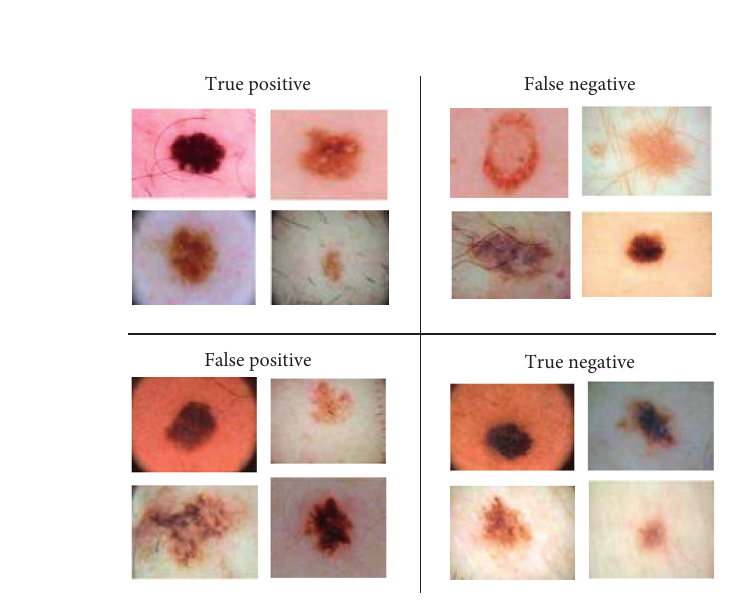
Figure 8: The four meaning conditions as per classification of image.